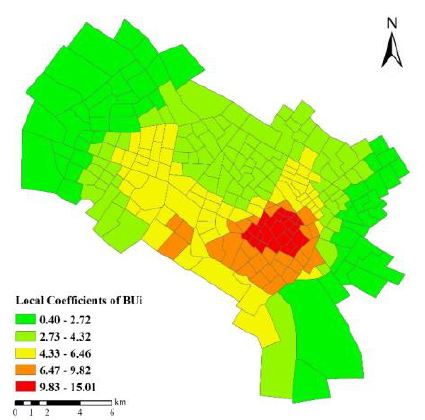
Figure 2. Local coefficients of EW i resulting from trip attraction models